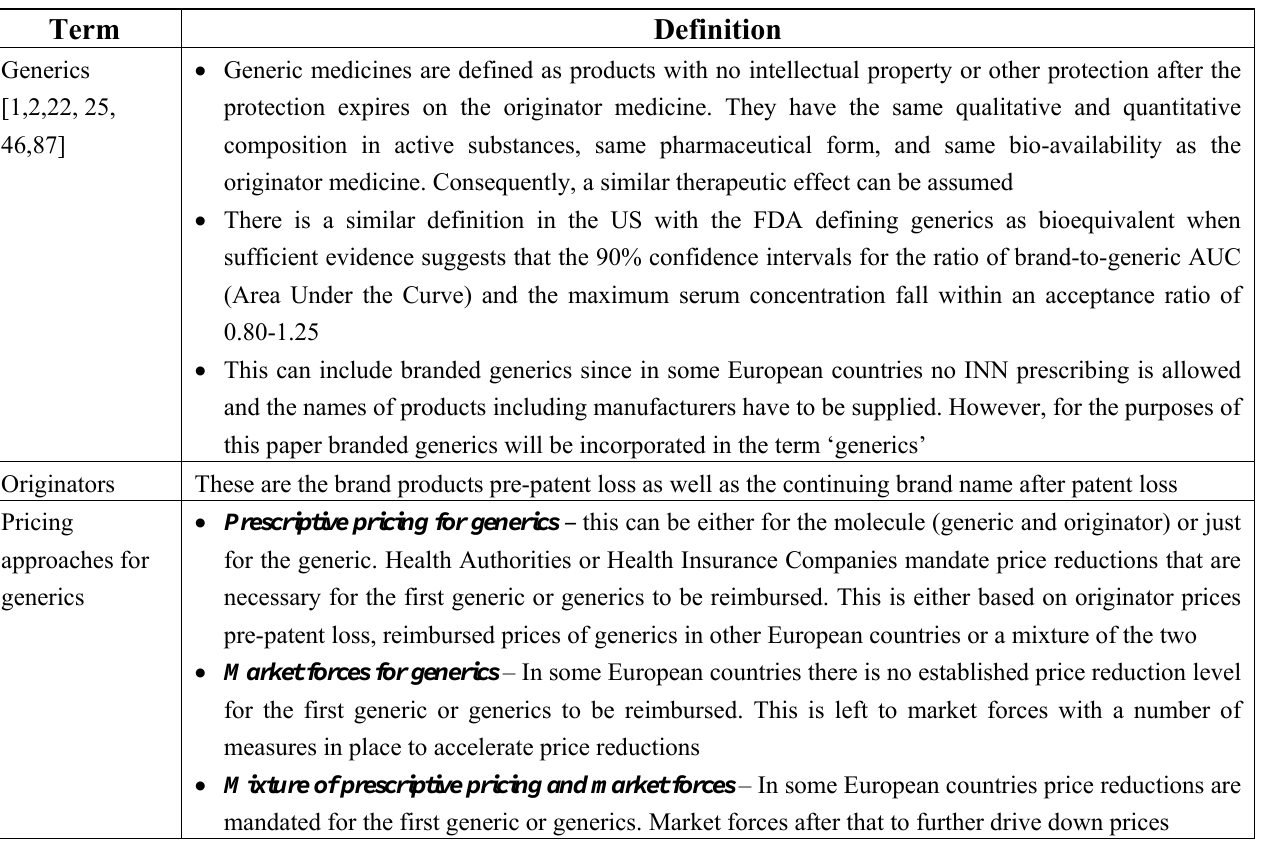
Table A1. Definitions used in the paper.